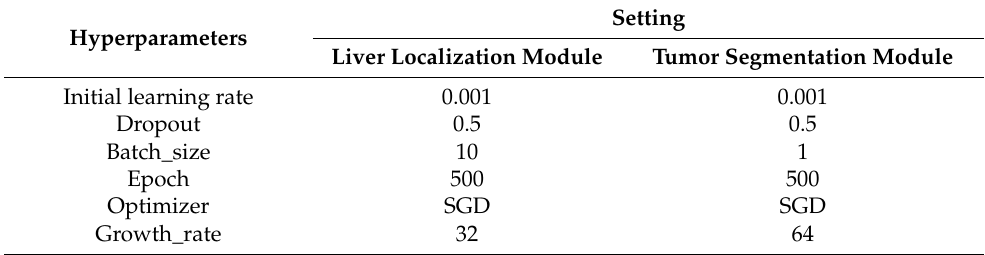
Table 2. Training hyperparameters of each module in the two stages of the algorithm.